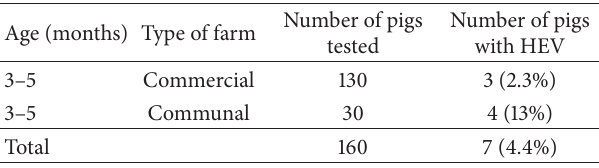
Table 1: Age-dependent prevalence of HEV RNA in the faeces of swine in Eastern Cape